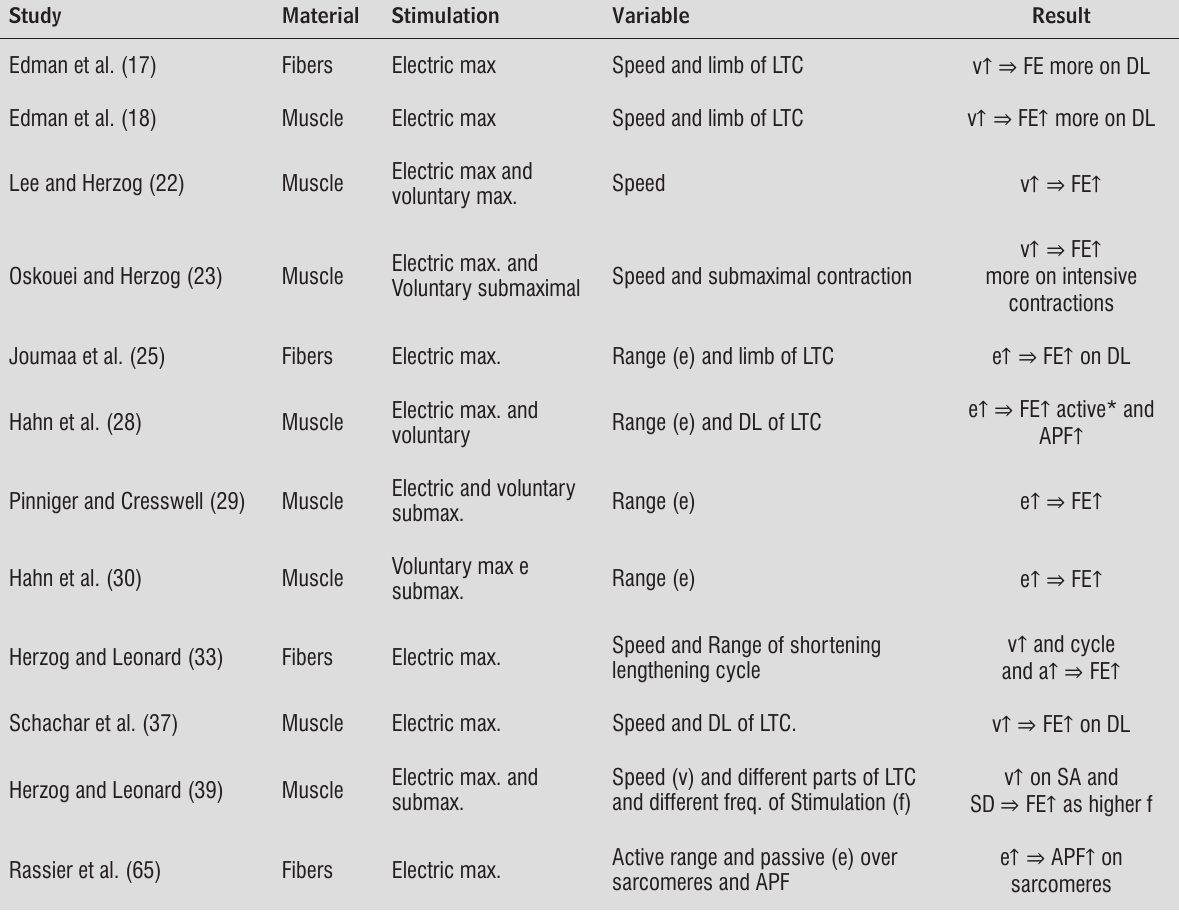
Table 2 - Main characteristics of the selected FE studies as on type of stimulation, the material used and the observed effects considering the characteristics of lengthening